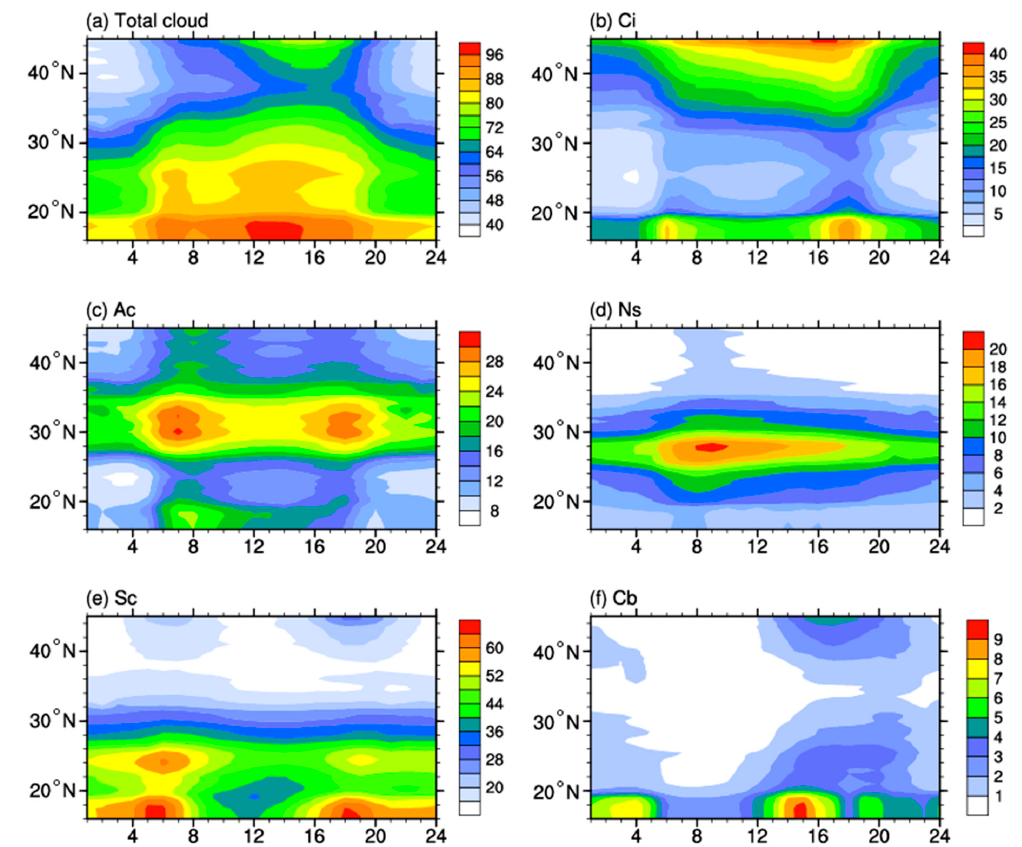
Figure 3. Diurnal variation cycles of occurrence frequency (%) of clouds with the latitude averaged over 110–120 ◦ E: ( a ) TC, ( b ) Ci, ( c ) Ac, ( d ) Ns, ( e ) Sc, and ( f ) Cb (the horizontal axis is the local solar time in hours, and the vertical axis represents the